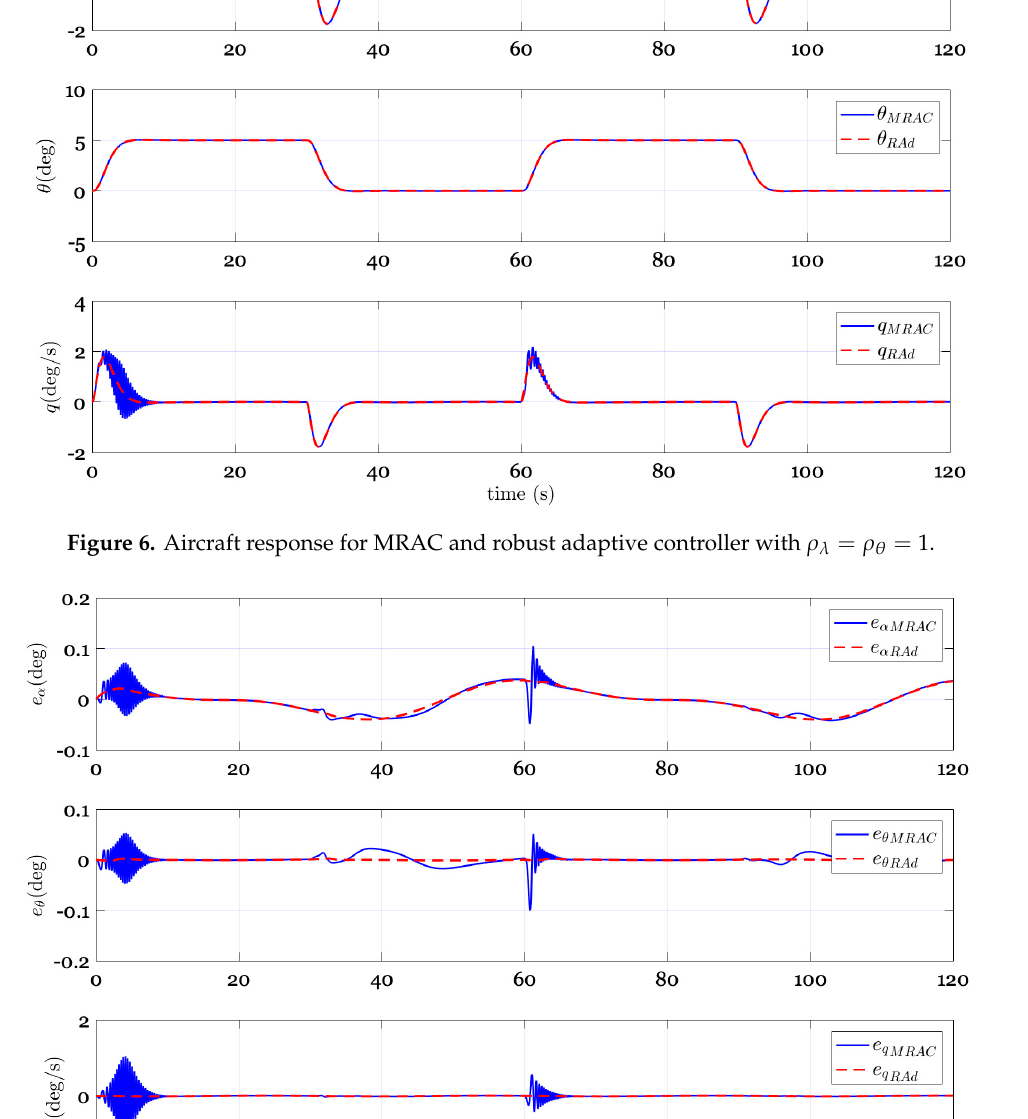
Figure 7. Status errors from MRAC and robust adaptive controller with ρ λ = ρ θ = 1 .